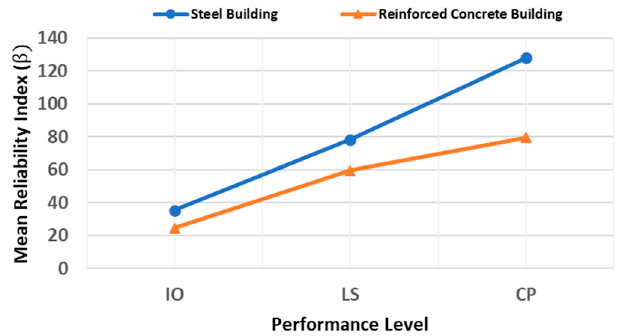
Figure 16. Mean reliability index for steel and reinforced concrete buildings located at Culiacan, Sinaloa (seismic zone B).